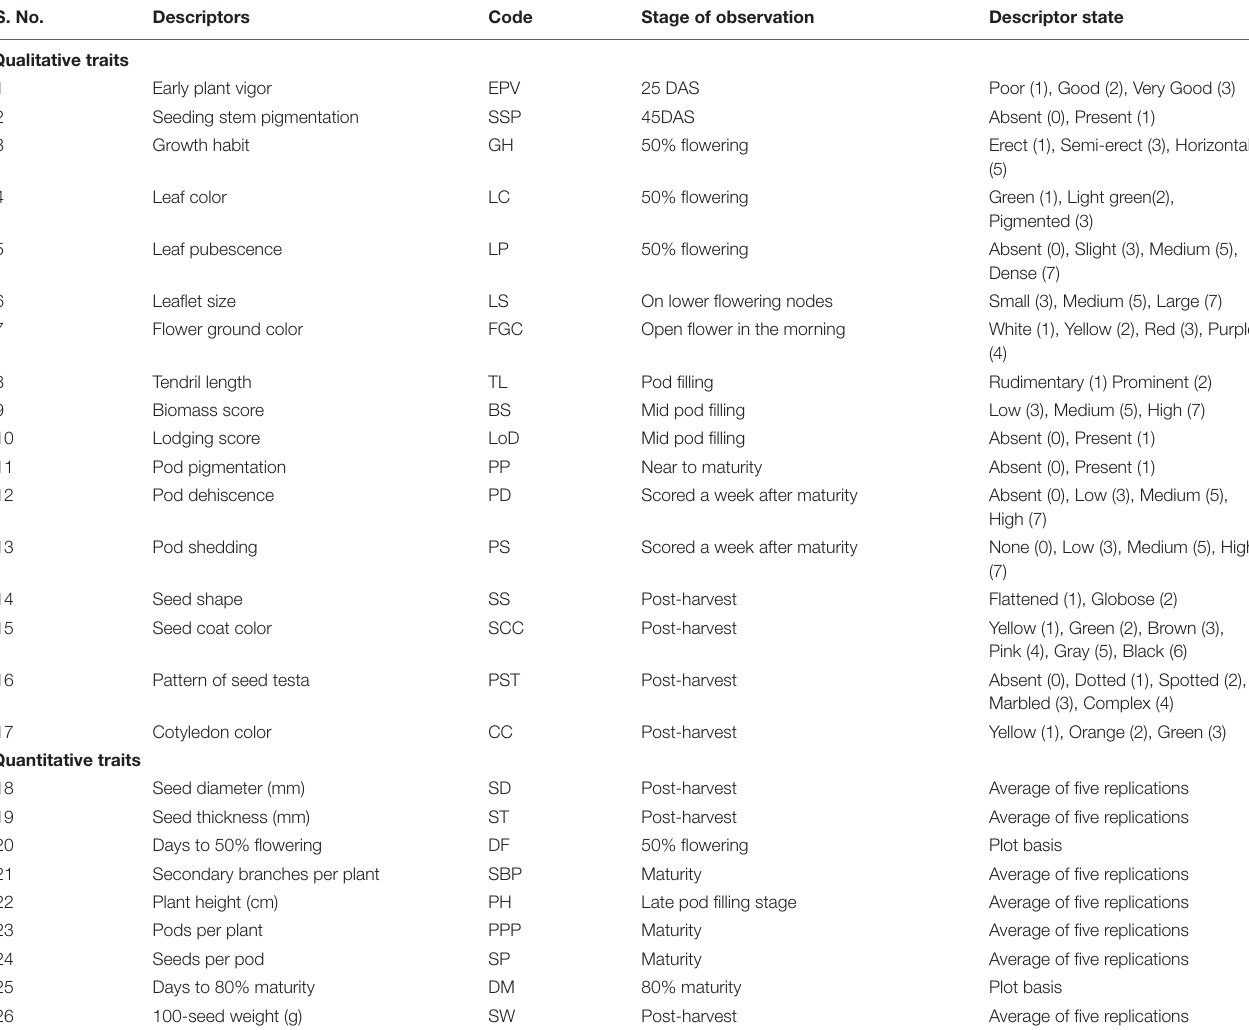
TABLE 1 | Descriptors used for agro-morphological characterization of lentil germplasm of Indian national genebank. S.